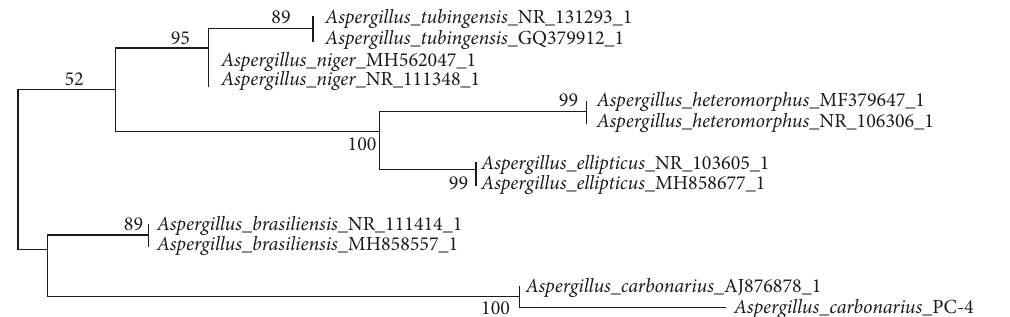
Figure 1: The neighborjoining tree inferred from the partial sequence of the ITS region dataset using Mega 6.0. The bootstrap was 2000 replications to assess the reliable level to the nods of the tree.